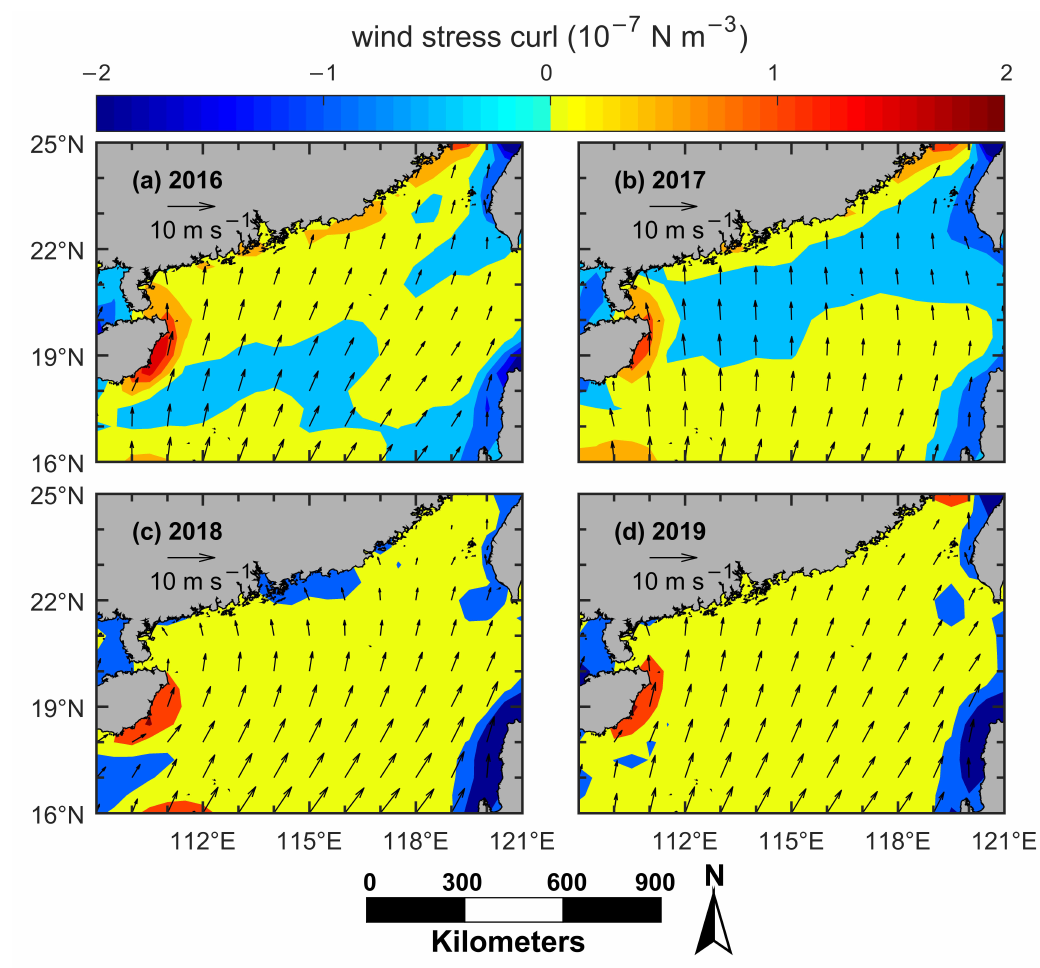
Figure 12. Boreal summer average sea surface wind (arrows, m s − 1 ) and wind stress curl (color, N m − 3 ) for 2016 ( a ), 2017 ( b ), 2018 ( c ), and 2019 ( d ). Note that the boreal summer excludes the months of May and